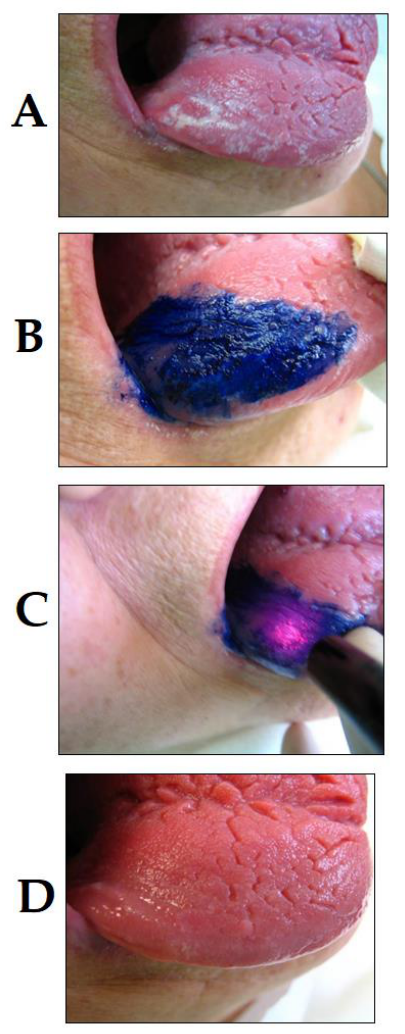
Figure 3. PDT of lingual candidiasis (photo courtesy of R. Szabó DMD, J. Arentz DMD and T. Nave DMD). A : C. albicans infection of the tongue before PDT treatment; B : application of PS compound; C : irradiation; and D : C. albicans infection of the tongue 36 h after PDT treatment, showing remission. In oral surgery, there is relevance in the use of PDT in both the prevention and treatment of alveolar osteitis and post-extraction pain [89]. This was proven in 2004, when Neugebauer et al. used the photosensitizer HELBO Blue and a diode laser to successfully reduce the prevalence of alveolar